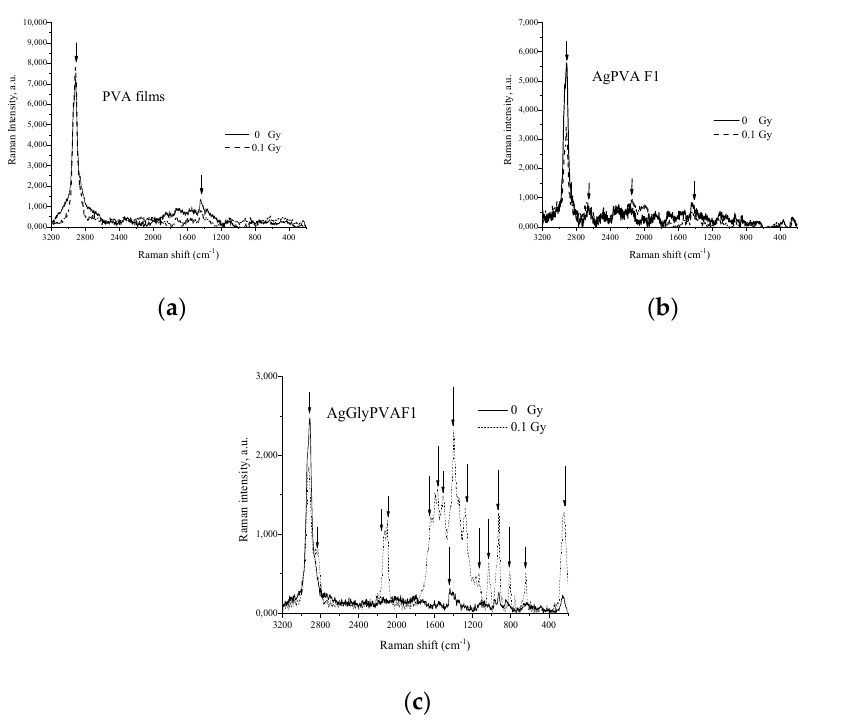
Figure 9. Raman spectra of PVA based films: ( a ) PVA, ( b ) AgPVAF1, and ( c ) AgGlyPVAF1 before and after X-ray irradiation (dose 0.1 Gy).